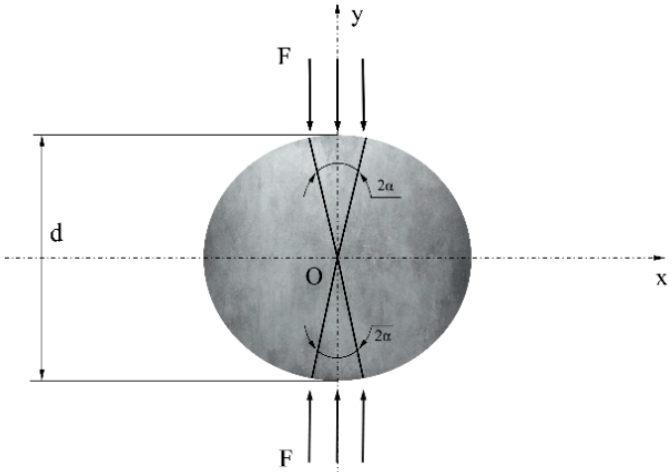
Figure 6. Force on flattened Brazilian disc.